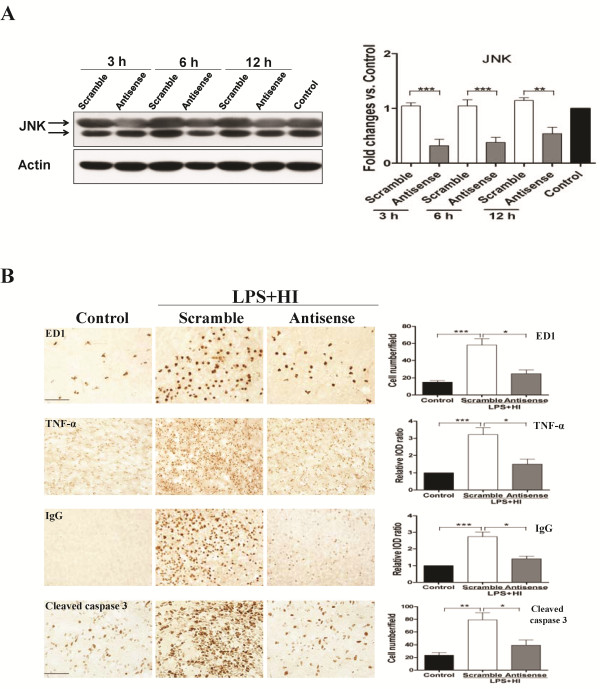
JNK antisense oligodeoxynucleotide significantly reduced neuroinflammation, blood–brain-barrier damage and apoptosis in the white matter after lipopolysaccharide-sensitized hypoxic-ischemia. (A) Immunoblotting of the white matter showed that intracerebroventricular infusion of c-Jun N-terminal kinase (JNK) antisense oligodeoxynucleotides (ODN) (n = 3) effectively suppressed JNK expression compared with scrambled ODN (n = 3) at 3, 6 and 12 h post-insult. (B) Antisense ODN treatment (n = 8) significantly attenuated upregulation of ED1-positive activated microglia, TNF-α immunoreactivities, IgG extravasation and cleaved caspase 3-positive cells in the white matter 24 h post-insult compared with scrambled oligodeoxynucleotide (n = 8). Scale bar =100 μm for ED1, TNF-α and IgG; 50 μm for cleaved caspase 3. Values are means ± SEM. ***P < 0.001, **P < 0.01, *P < 0.05.